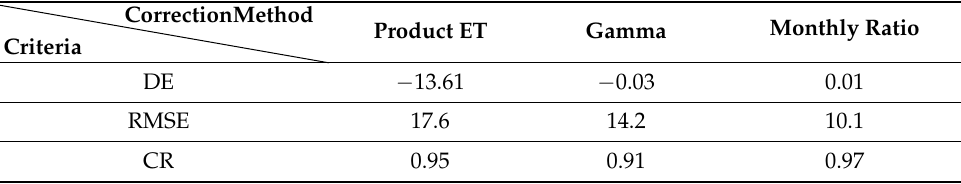
Table 4. Bias (mm/month), RMSE (mm/month), and CORR of the correction methods in comparison with the reference ET